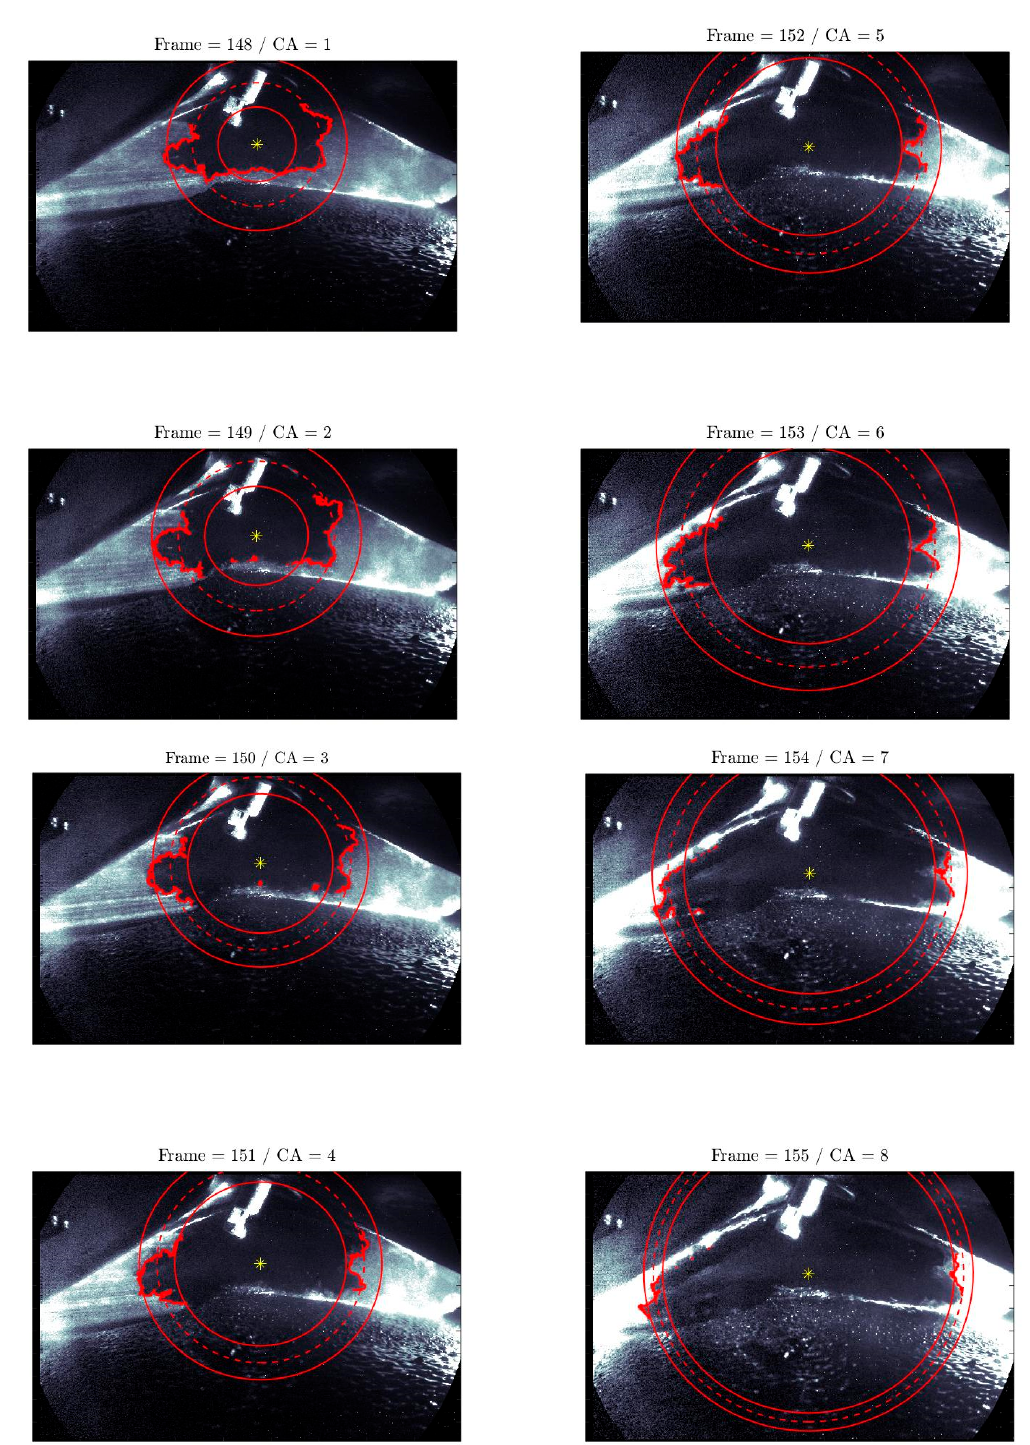
Figure 11. Cycle 58. Background corrected images of turbulent flame from − 7 CAD to TDC firing. Superimposed geometric properties: flame edges, flame center, min, max, and average radii. Engine operation: 1000 RPM, wide open throttle.